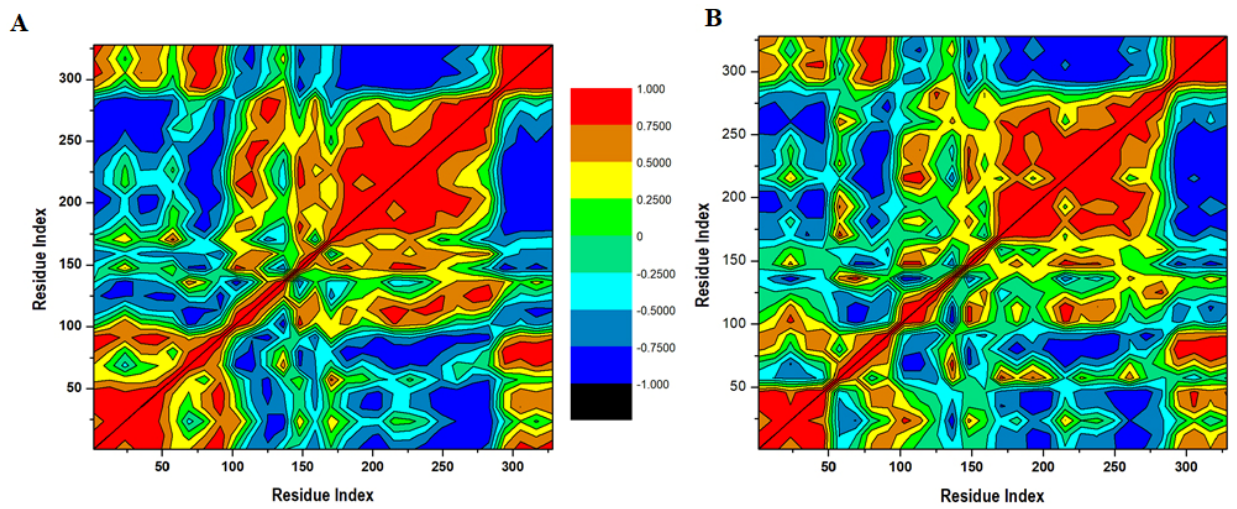
Figure 6. Dynamics cross-correlation matrix analysis ( A ) apo MARK4 enzyme and ( B ) irisin-MARK4 complex calculated after 100 ns of MD trajectories.